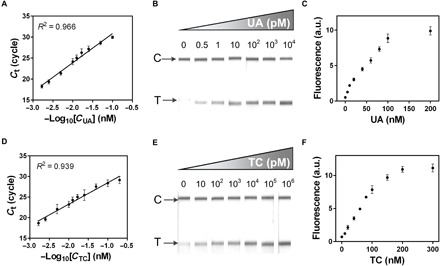
Development of UA and TC biosensors using aTF-NAST.(A to C) Performance of UA biosensors coupling HucR-NAST with, respectively, RT-qPCR, RPA, and RCA output. (D to F) Performance of TC biosensors coupling TetR-NAST with, respectively, RT-qPCR, RPA, and RCA output. For RCA output, here, we measured the fluorescence signal. In (A), (C), (D), and (F), the results shown are the averages of three independent experimental replicates with ±SD. In (B) and (E), the results shown are representative examples for multiple similar datasets.